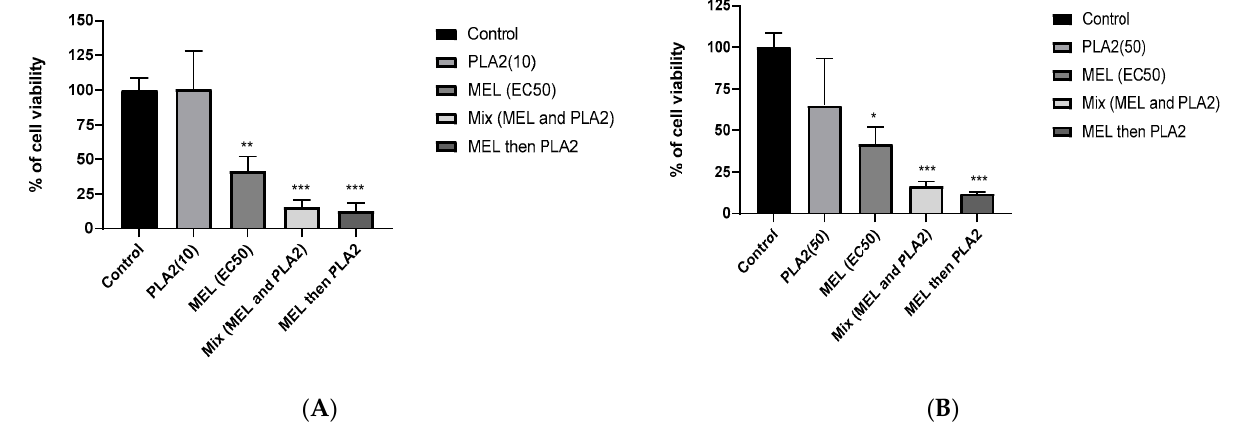
Figure 3. Synergistic effect of MEL and PLA2 on the viability of HCT116 cell lines. HCT116 cells were treated with PLA2 ( A ) (10 µ g/mL), or ( B ) (50 µ g/mL) and MEL (14.05 µ g/mL) simultaneously or after a pretreatment delay. Pretreatment delay corresponds to addition of the MEL 30 min before the PLA2. The data are expressed as the means ± SD (n = 3), * p < 0.05, ** p < 0.01, *** p < 0.001 compared with untreated cells